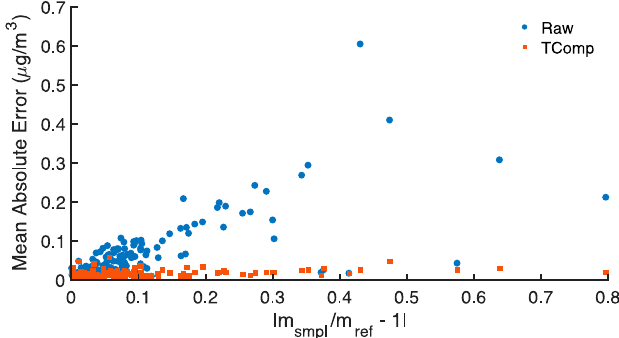
Figure 8. Mean absolute error (MAE) of uncompensated (Raw) and temperature-compensated (TComp) black carbon (BC) concentrations reported by 150 ABCD optical cells with HEPA-filtered inlets, as a function of the slope ratio’s absolute deviation from unity (|m smpl /m ref − 1|). The MAE of 60-min time base BC concentrations is evaluated relative to the desired zero response (0 μ g m − 3 ).